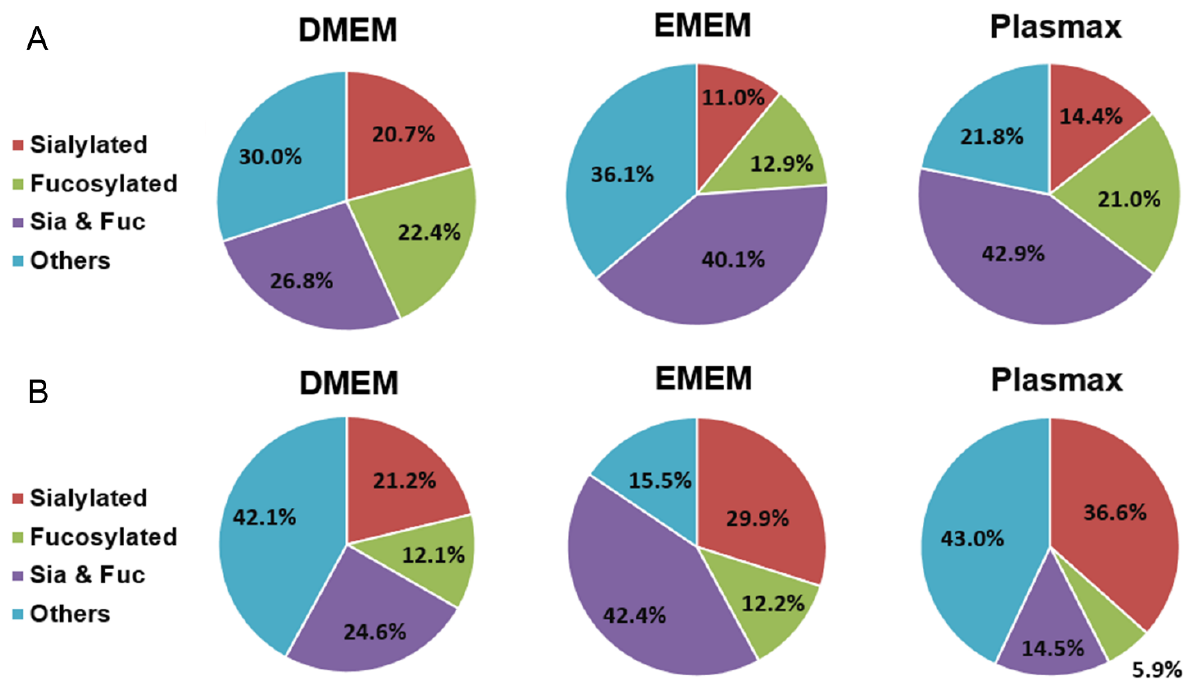
Figure 6. Distribution comparison of different types of O -glycans derived from ( A ) the 231BR cell line and ( B ) CRL cell line cultivated in DMEM, EMEM, and Plasmax. Table 2. Expression discrepancies of different types of O -glycans derived from the 231BR and CRL cell lines in three media. The numbers in brackets are standard deviations (n = 3). p -values were calculated using Student’s t -tests to indicate the significant level of differences.